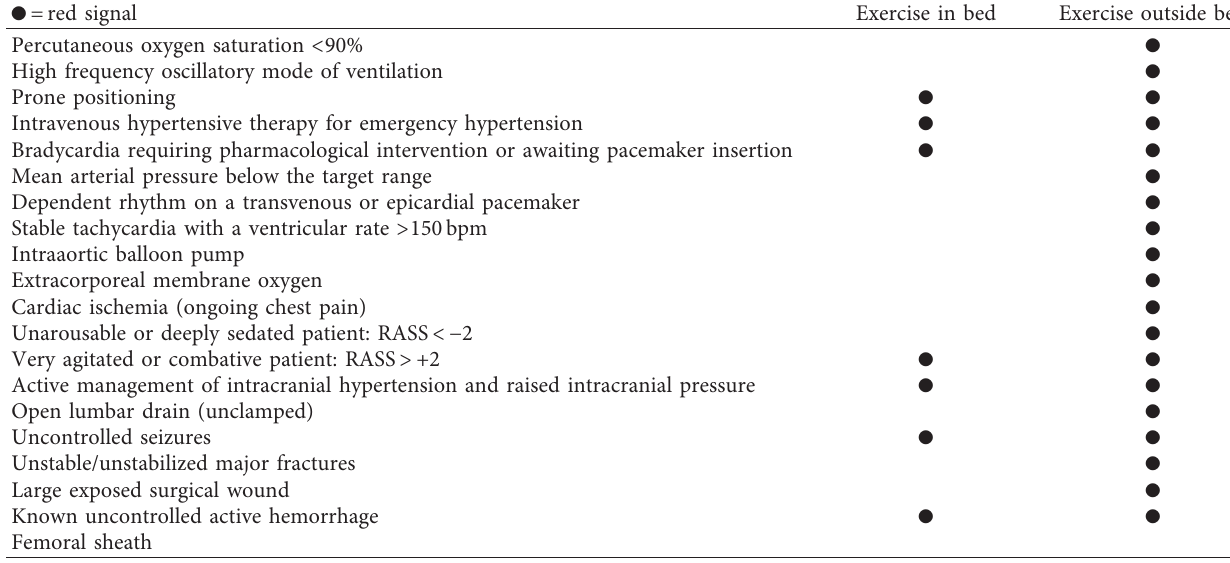
Table 6: Red signals for active mobilization of mechanically ventilated patients.